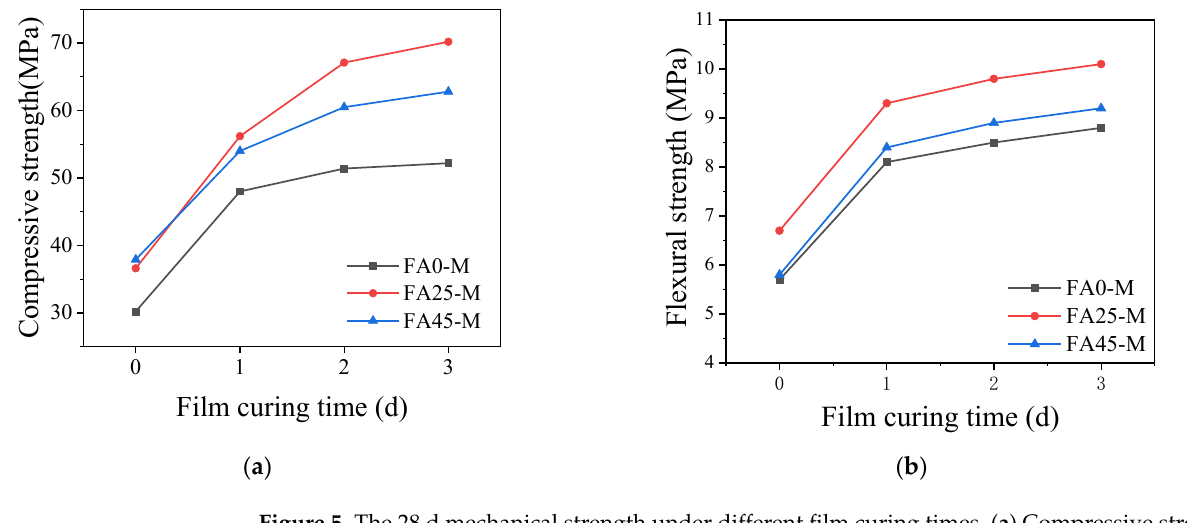
Figure 7. The XRD patterns of FA0-P under different curing systems. Figure 8 shows the thermal analysis test results of FA0-P under the SC and HD curing systems. As shown in Figure 8, under different curing systems, the trend of the curves is basically the same, but there is a great difference in the peak intensity. This indicates that the hydration products of FA0-P under the SC and HD curing systems are basically the 0